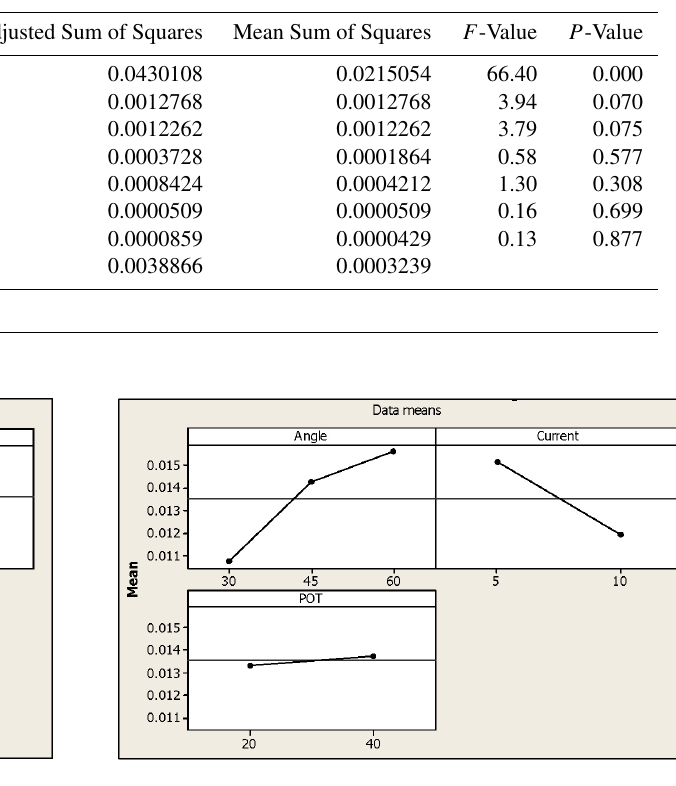
Figure 6. Main effect plots of mean kerf width. Figure 7. Main effect plots of mean surface